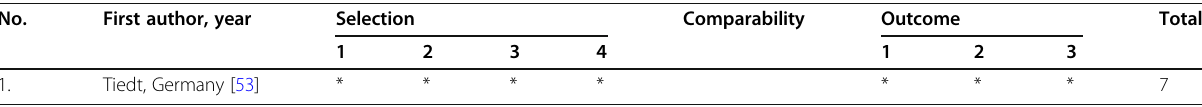
Table 2 Newcastle-Ottawa scale (cohort study)